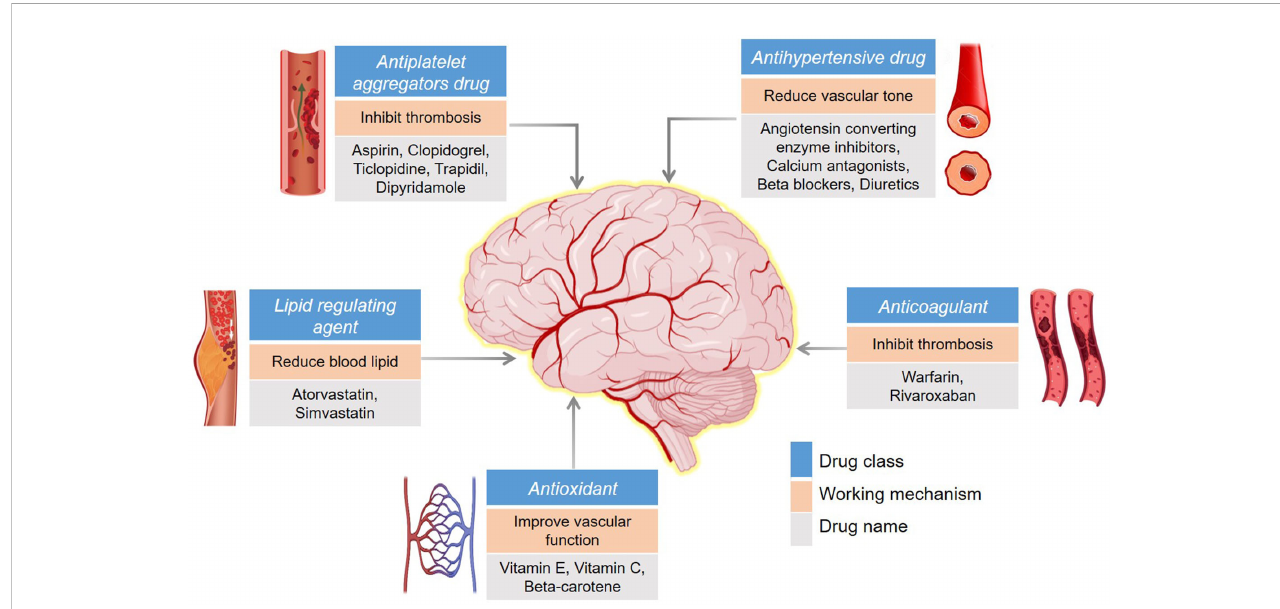
FIGURE 2 Common drugs for the prevention/treatment of stroke. The background color differentiates the drug class, working mechanism, and drug name as